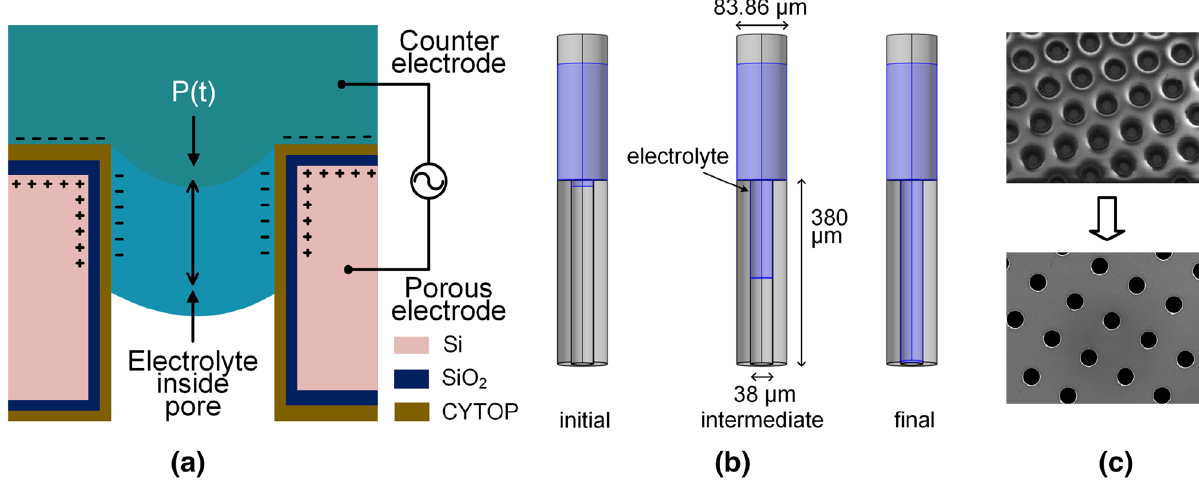
Figure 1. Overview of a high-surface area REWOD energy harvester, ( a ) working mechanism of REWOD with pulsating pressure P ( t ), ( b ) initial, intermediate, and final states of the electrolyte in a pore due to pulsating pressure, ( c ) etched pores using plasma deep reactive ion etching (DRIE).